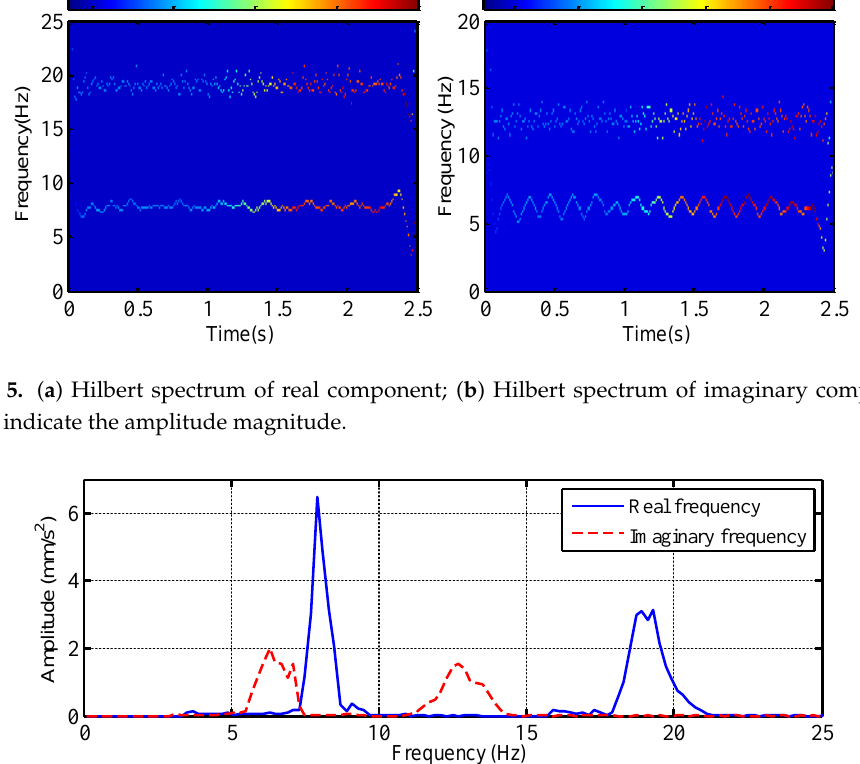
Figure 7. ( a ) The correlation coefficient of each true IMF; ( b ) the frequency of each true IMF; ( c ) calculation time for the BEMD procedure. The degree of stability of the correlation coefficient and frequency for the true IMFs is shown in Figure 8. In light of the indicators from the above figures, it is clearly seen that the correlation coefficient and frequency components of the signals are almost stable when the direction number is greater than 16. On the other hand, the computational efficiency of the BEMD algorithm gradually reduces with increasing projection number. In general, the ideal number of projection directions is 16, which provides a basis for subsequent BEMD operations.